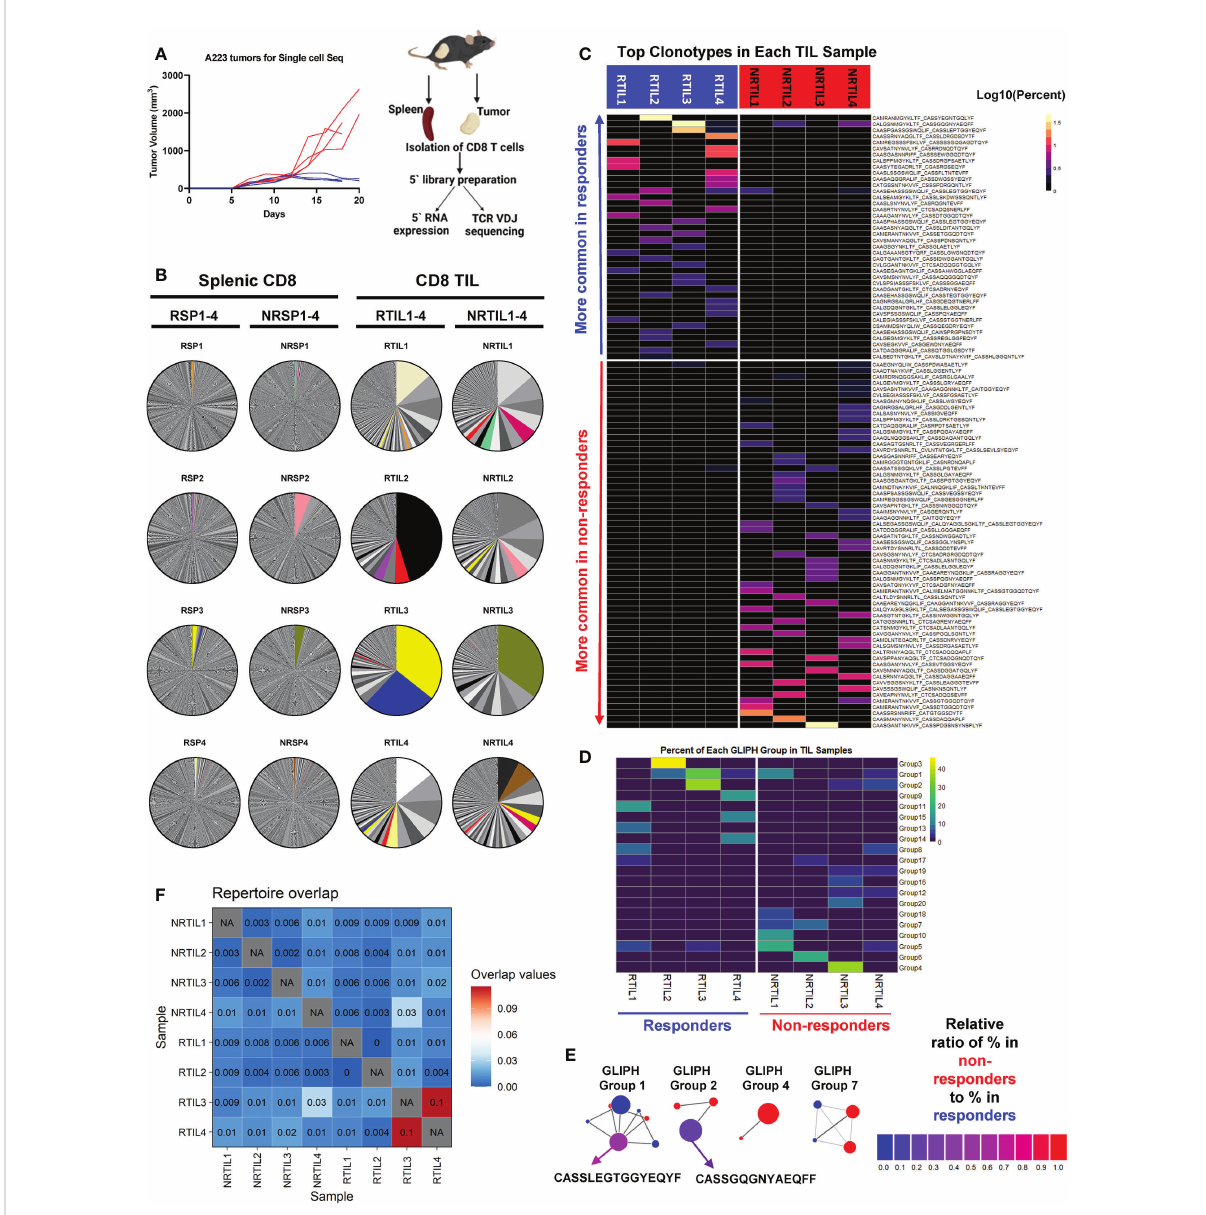
FIGURE 3 Top TCR clonotypes appear to be mutually exclusive in responder (R) vs . non-responder (NR) CD8 TILs. (A) Left panel: Tumor growth curves of R (RCTV<0, blue, n=4) and NR (RCTV>1.5, red, n=4) mice. Right panel: experimental scheme for single-cell sequencing. Tumors and spleens were harvested on day 20 for cohort 1 and 2 or day 18 for cohort 3 and 4 after tumor inoculation. CD8 T cells were isolated and subjected for coupled scRNA-seq and single-cell TCR V(D)J sequencing (both CD8 TIL and splenic CD8 T cells) using 10×Genomics platform. (B) Distribution of TCR clonotypes (de fi ned as paired a.a. sequences of CDR3 a and CDR3 b regions) in R (RTIL1-4) and NR (NRTIL1-4) CD8 TILs as well as R (RSP1-4) and NR (NRSP1-4) splenic CD8 T cells. In each sample, a single pie slice represents the percent of cells harboring the same TCR clonotype in the entire sample. Clonotypes shared between samples are colored. (C) Heatmap of top clonotypes (>1% of a given sample) sorted by average abundance in R vs . average abundance in NR. Clonotypes are colored according to the log10 percent in each sample. (D) Heatmap of top 20 GLIPH groups identi fi ed in 8 TIL samples (RTIL1-4, NRTIL1-4) based on TCR b CDR3 sequences. Groups are ordered based on their average percent in R samples (RTIL1-4) vs . average percent in NR samples (NRTIL1-4). (E) Network plots of GLIPH groups (Groups-1, 2, 4, 7). Each node means a TCR b CDR3 sequence, and each line means a global (thick line) or local (thin line) similarity to another CDR3 sequence within the group. Node sizes represent overall abundance in samples and nodes are colored based on the relative ratio between their percent in NR (red) samples vs . in R samples (blue). Relative ratio = (average % in NR)/(average % in R + average % in NR). The shared clonotype ’ s node within Group 1 or 2 was colored purple and labeled with its corresponding TCR b CDR3 a.a. sequence. (F) TCR repertoire overlap in R and NR TIL samples. The overlap coef fi cient was calculated in a pairwise manner between each sample using repOverlap function in immunarch package and the resulting matrix is